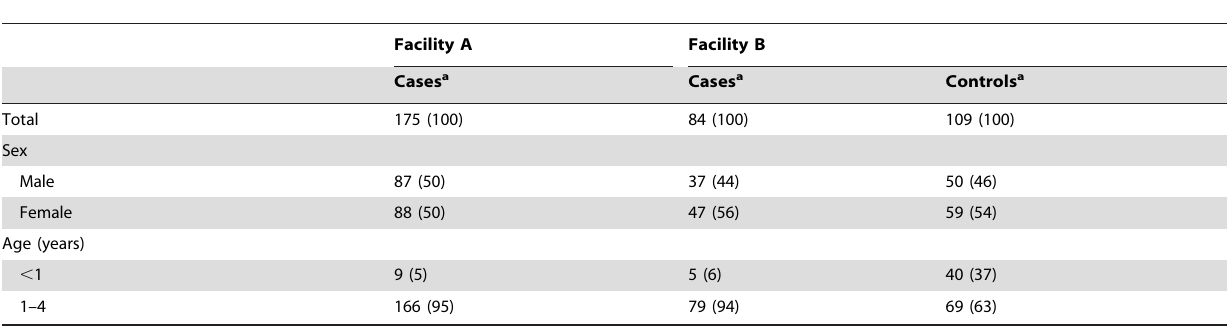
Table 2. Demographic characteristics of American Indian molluscum contagiosum case and control patients , 5 years old by